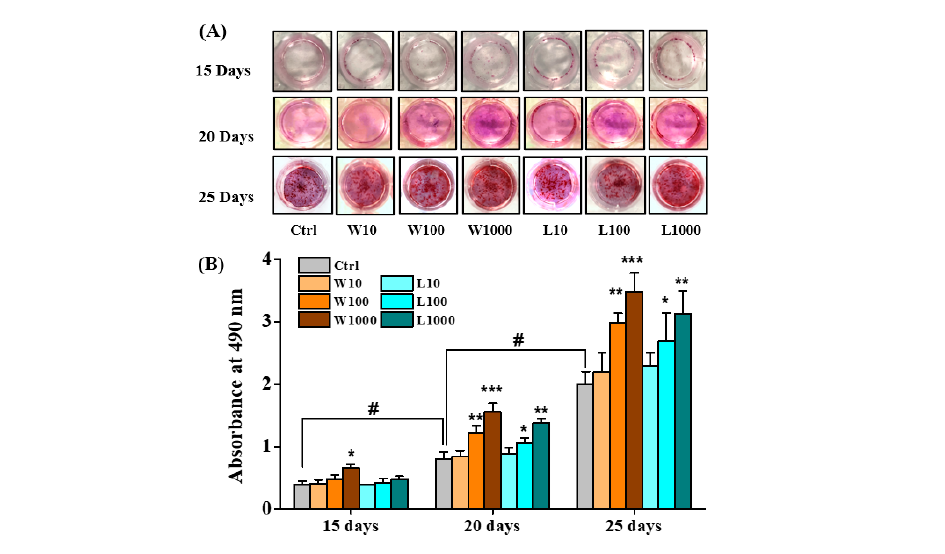
Figure 3. Effects of whey protein hydrolysates (TA2H and LPH) on mineralization in preosteoblast cells. MC3T3-E1 cells were incubated with differentiation medium containing 0 (control group), 10, 100, and 1000 μ g/mL of TA2H and LPH for 15, 20, and 25 days prior to being stained with Alizarin Red S. ( A ) Representative images of mineralization were taken. ( B ) Absorbance at 490 nm was measured after distaining with cetylpyridinium chloride. Data are represented as the mean ± SEM, n = 3. *, **, and *** indicated p < 0.05, p < 0.01, and p < 0.001, as compared to the control group. # indicated p < 0.05 of the control group between day 15, 20 and 25.